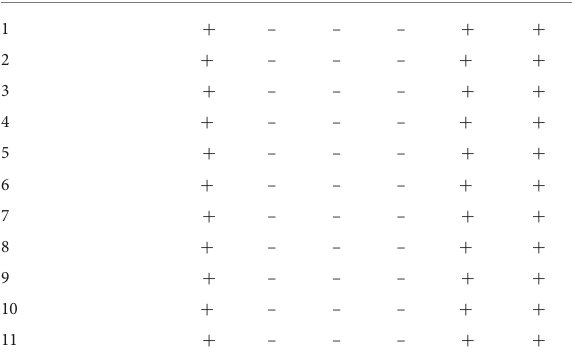
TABLE 3 Hair-related keratins and epithelial keratins expression in the nail bed of